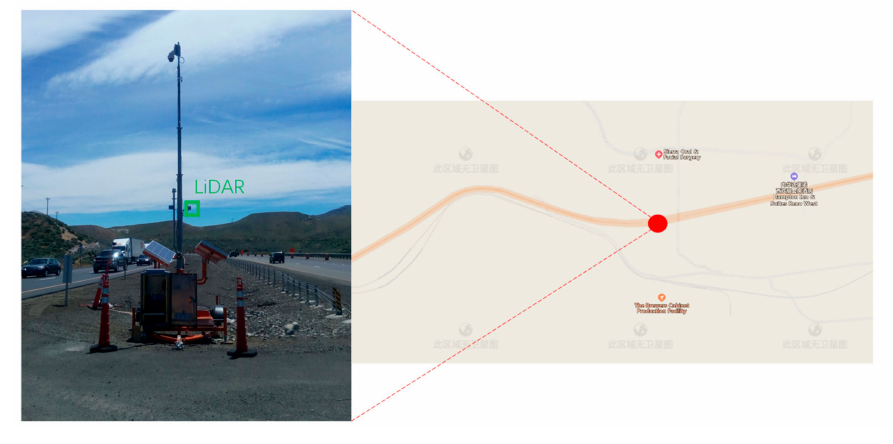
Figure 1. Testing